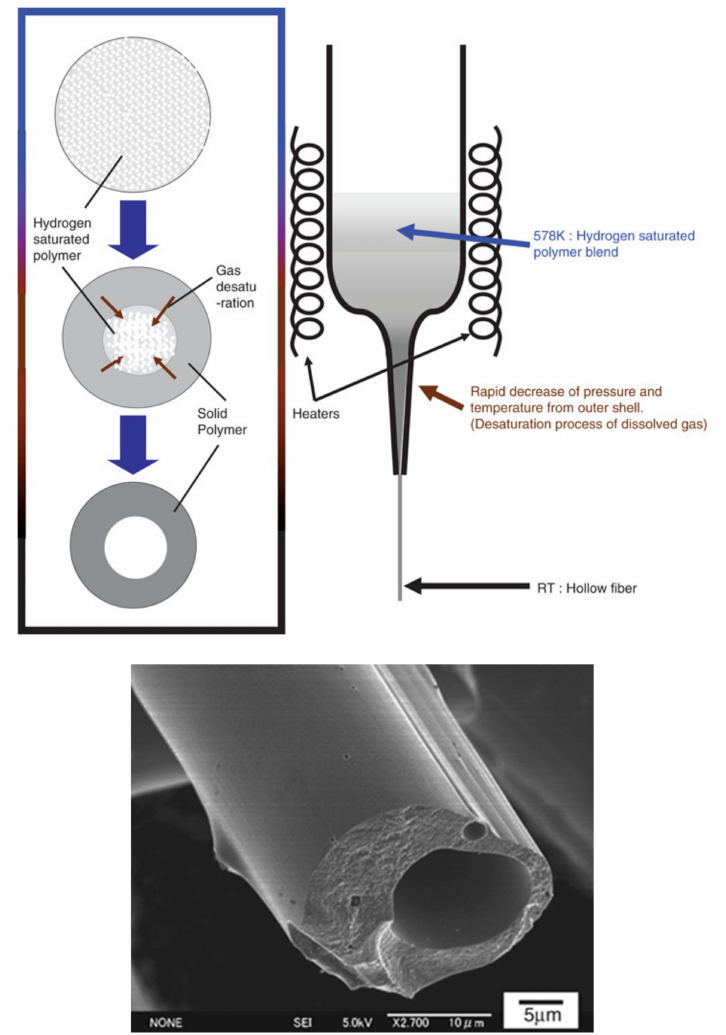
Figure 13. Schematic of the organically modified ceramics (ORMOCER) technique and the SEM image of the prepared porous hollow fiber. Reprinted with permission from [99]. Copyright © 2009 The America Ceramic